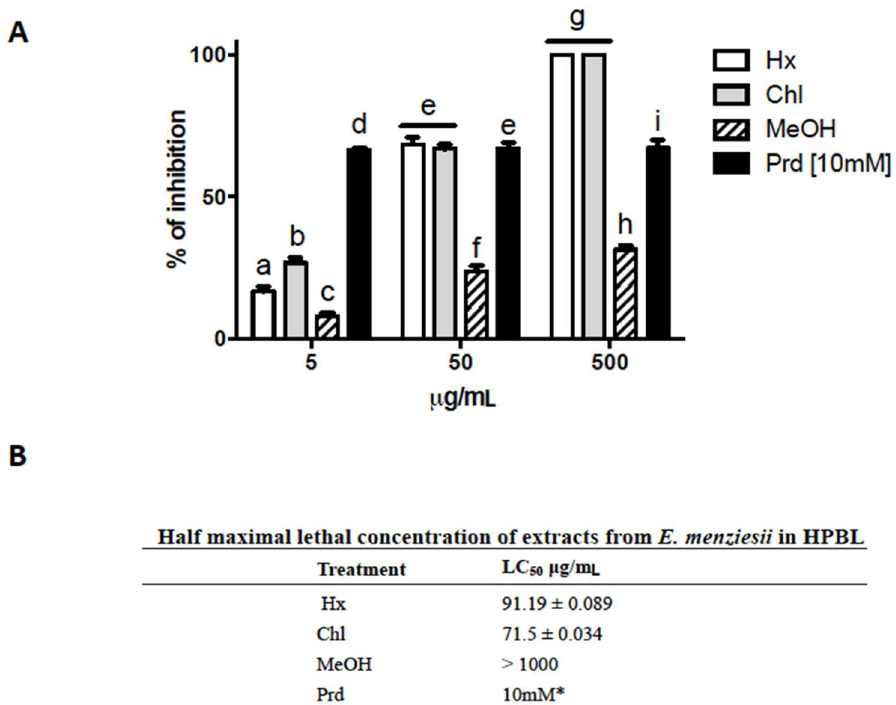
Figure 2. Cytotoxic activity of E. menziesii ’s extracts over human peripheral blood lymphocytes (HPBL). ( A ) Percentage of growth inhibition of HPBL by the treatment with 5, 50 or 500 µ g/mL of hexane (Hx), chloroform (Chl) or methanol (MeOH) extracts obtained from E. menziesii seaweed for 24 h. * 10 mM Partenolide [25], and PBS 1X were used as positive and negative controls, respectively. Data are expressed as the mean ± SEM at least of three independent experiments. Statistical differences were determined by two-way ANOVA, and differences between groups by Tukey’s test with multiple comparisons. a–i nomenclature: the same lowercase letters on each bar mean there are no significant differences among treatment values; conversely, distinct letters indicate significant differences within treatments. ( B ) Half lethal maximal concentration (LC 50 ) of Hx, Chl and MeOH extracts, and LAA was determined by linear regression.